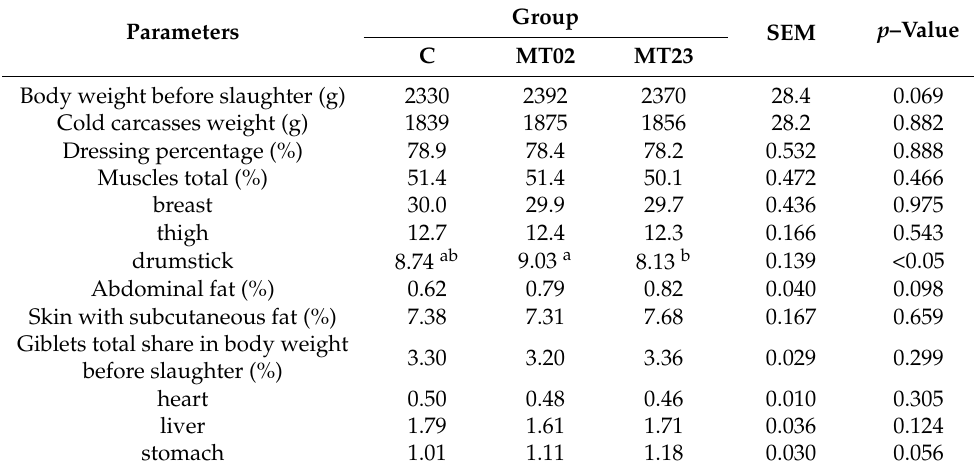
Table 4. Slaughter analysis of broiler